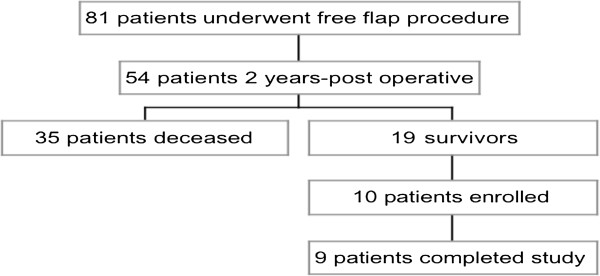
Patient breakdown.